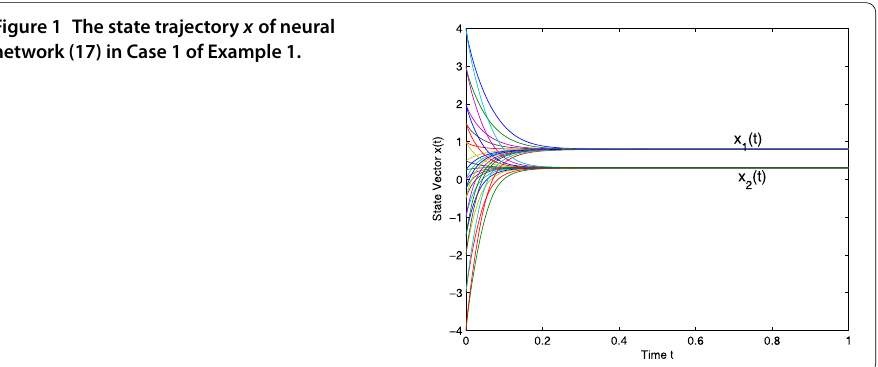
Figure 1 The state trajectory x of neural network (17) in Case 1 of Example